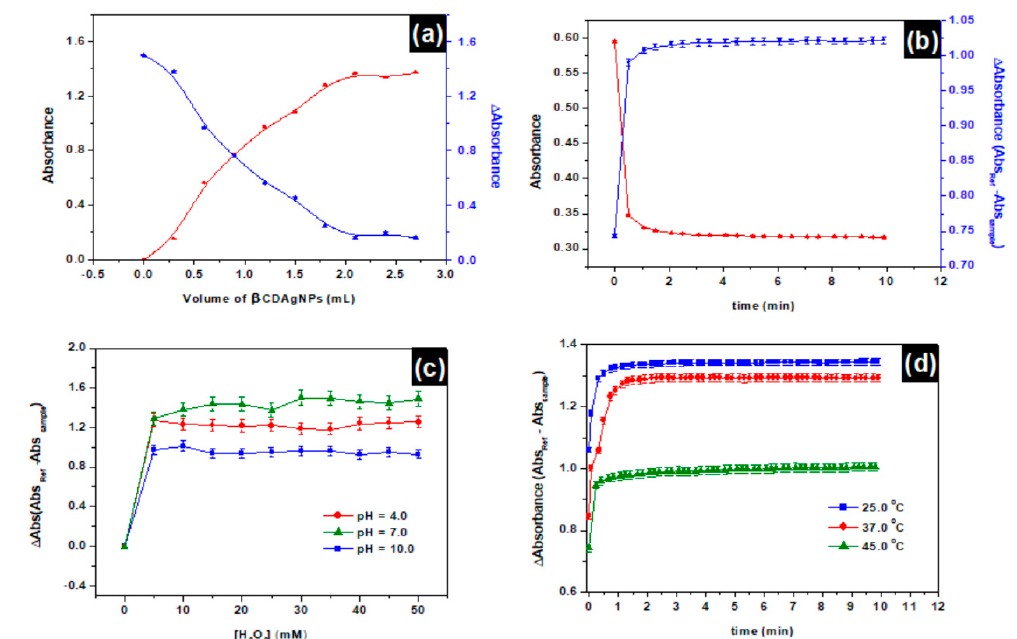
Figure 2. ( a ) Effect of β CD-AgNPs volume on the detection of H 2 O 2 , Experiment condition [H 2 O 2 ] = 40 mM, equilibrium time (3 min), pHi = 9.28, T = 22.5 ◦ C. ( b ) Impact of time (kinetic) of H 2 O 2 recognition by β CD-AgNPs as a function of equilibration time at 25 ◦ C; [H 2 O 2 ] i = 40 mM; V (AgNPs)= 0.75 mL; pHi ( β CD-AgNPs ) ~ 9.28; ( c ) Effect of different pH on H 2 O 2 by β CD-AgNPs . Experiment condition [H 2 O 2 ] = from 1.0 to 50.0 mM increasing with a step of 5.0 mM, equilibration time (3 min), T = 25 ◦ C. ( d ) Kinetic of the effect of temperature on H 2 O 2 detection by β CD-AgNPs ; V( β CD- AgNPs ) = 0.75 mL; pH = 9.28; [H 2 O 2 ] i = 40.0 mM; Absorbances in all experiments are recorded at LSPR λ max = 384 nm and nanoparticles were diluted 3